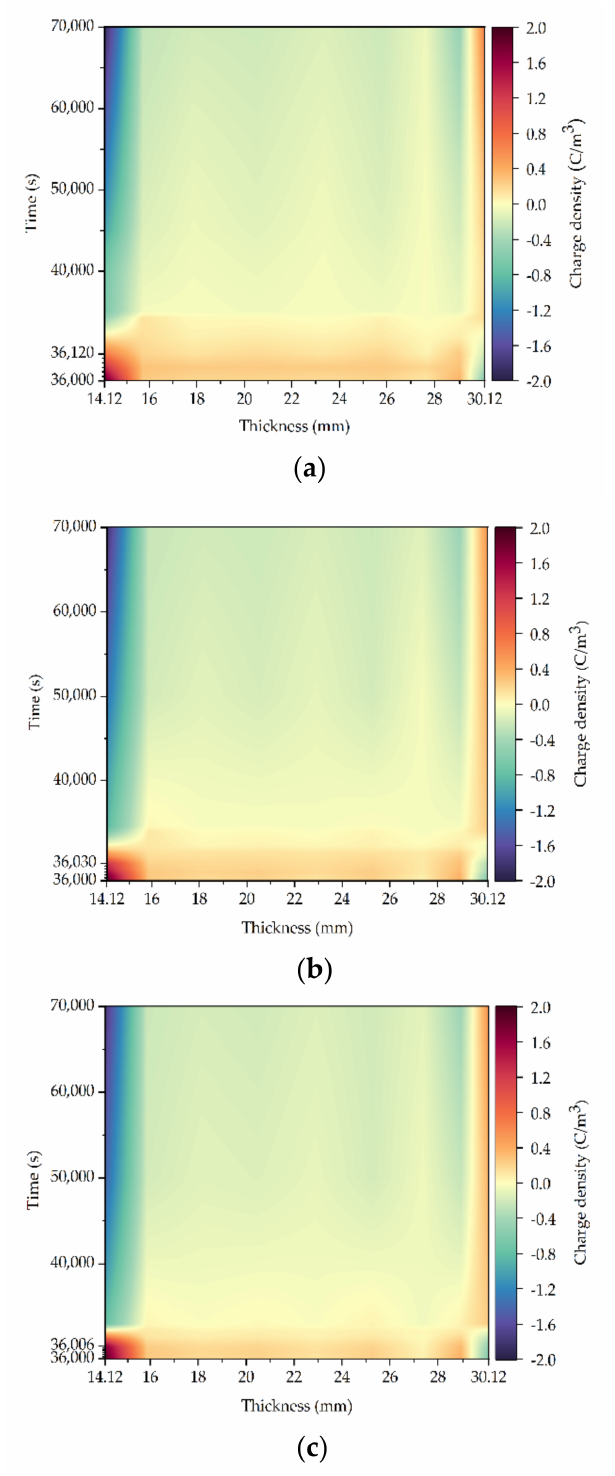
Figure 7. Space charge evolution in the HVDC extruded cable at load current of 1000 A, under the applied DC voltage shown in Figure 3 with different PRPs: ( a ) 120 s; ( b ) 30 s; ( c ) 6